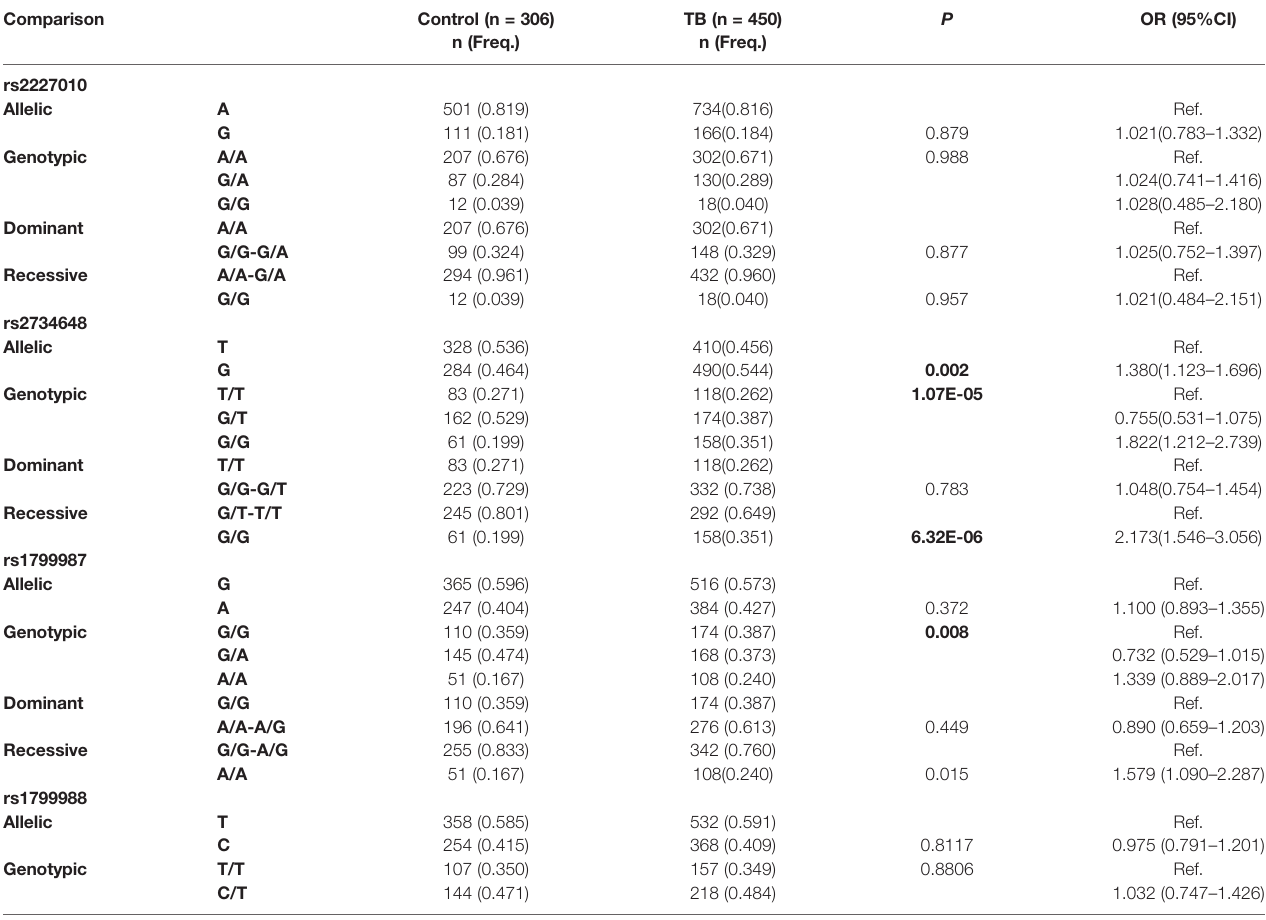
TABLE 2 | Comparison of allelic and genotypic frequencies of CCR5 gene between TB patients and controls.